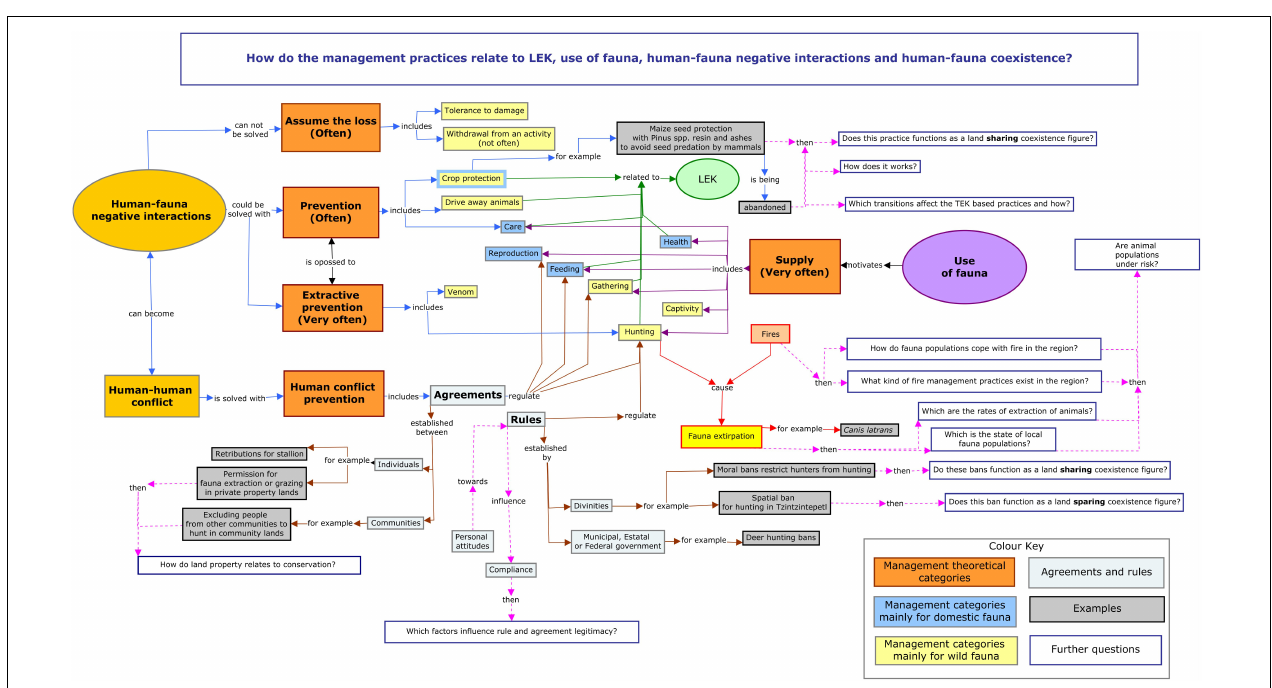
FIGURE 5 | General management scheme linking categories, examples, and further questions. Five management categories are shown. In the left side are those that respond to management of negative interactions between humans and fauna and human-human conflicts: assume the loss, prevention, extractive prevention, and human conflict prevention. The right side shows the supply which is motivated by the use of animals. Each of these five management categories include substantive categories which are non-exclusive. Yellow boxes show categories mainly related to wild fauna, while blue boxes show categories related mainly to domestic fauna. Crop protection contains both colours since it is related to both wild and domestic fauna. In the centre of the figure, local ecological knowledge (LEK) is related to several management practices for the prevention of damages to supply. Agreements are set to prevent human conflicts related to fauna supply decisions such as wild fauna extraction and domestic fauna reproduction. Rules also regulate hunting. Hunting and fires (orange boxes) have been recognised by interviewed persons as the main causes of fauna extirpation. Examples and further questions that arose in the process are included. This figure was elaborated with Cmap (https://cmap.ihmc.us/). A simplified version of this figure is available in Supplementary Additional File 5